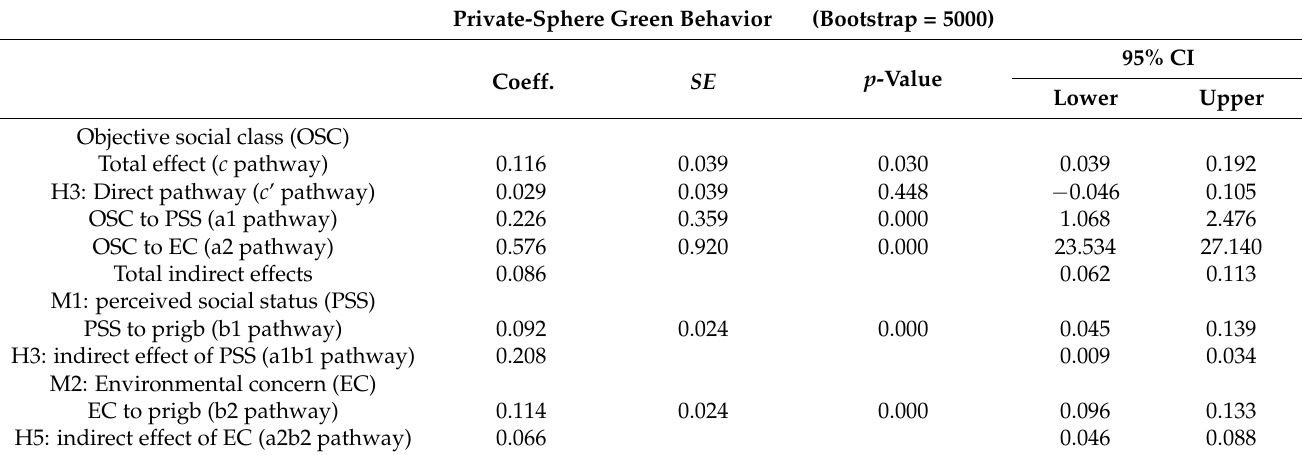
Table 5. Results of the parallel mediating analysis.